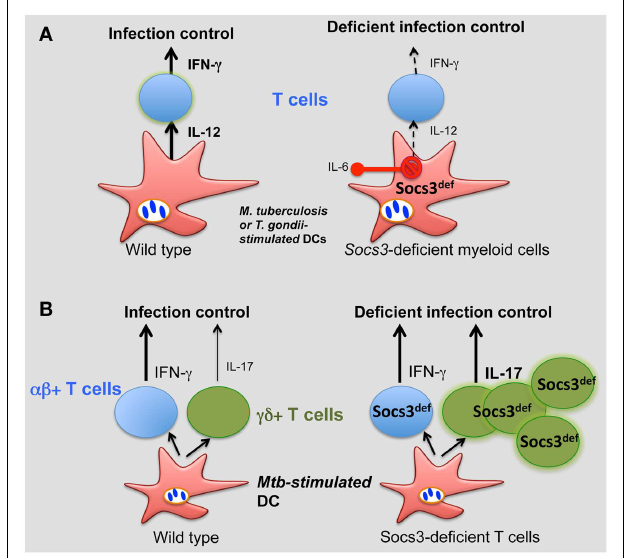
FIGURE 2 | Role of SOCS3 in the control of infection . (A) During M. tuberculosis and T. gondii infection, SOCS3 is induced in macrophages and DCs prevents the IL-6-mediated inhibition of IL-12 secretion, promoting a CD4 + cell-dependent IFN- γ expression. (B) SOCS3 controls the development of γδ + T cells. Such control is critical for proper protection against M. tuberculosis